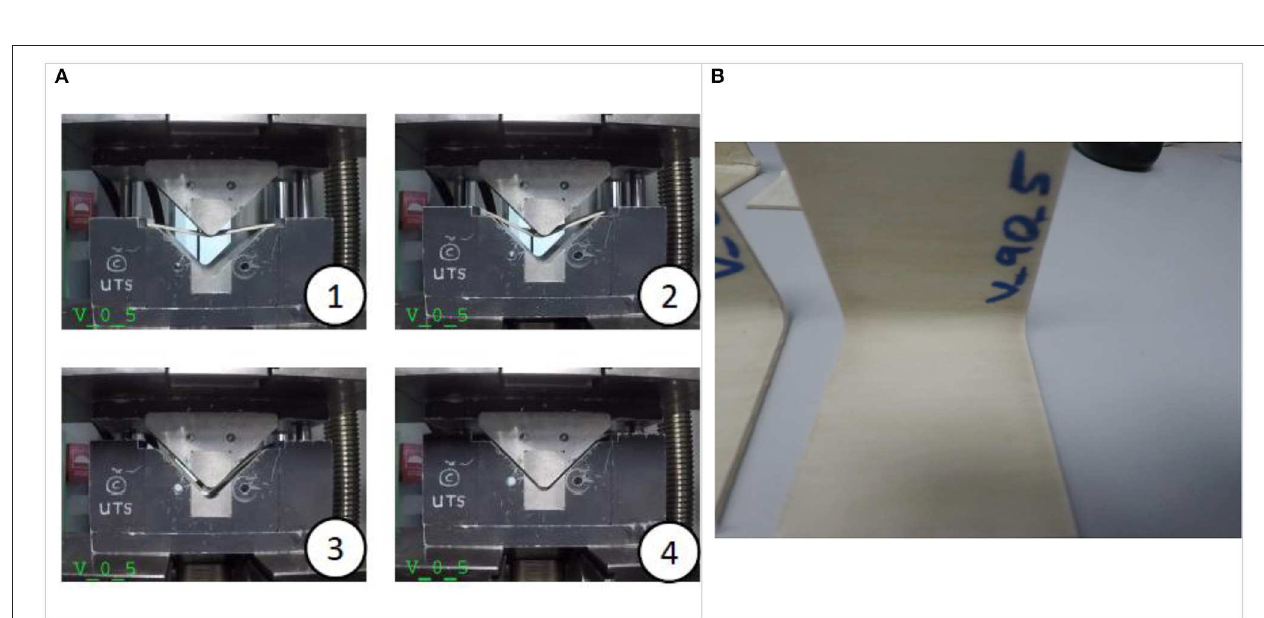
Frontiers in Materials |